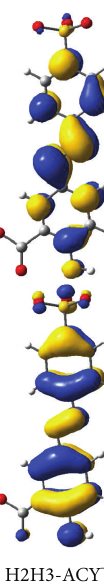
Figure 2: Isodensity surfaces (0.03 e/bohr 3 ) of the key molecular orbitals of the single deprotonated forms of the dye calculated at DFT/B3LYP/6-31+G(d) level in water.